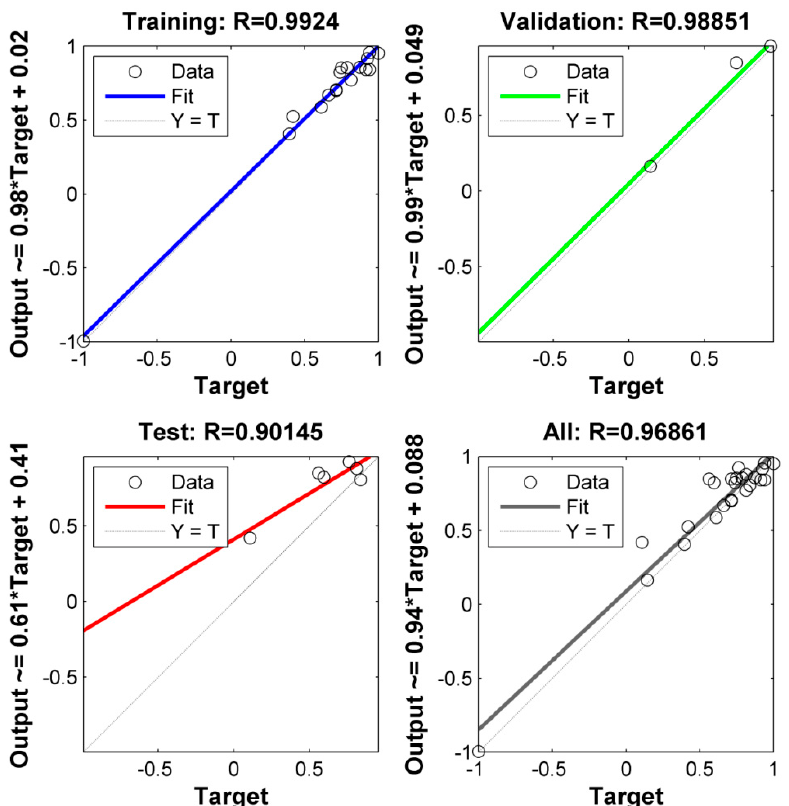
Figure 5. Training, testing, and validation performances of the 4-3-3-1 neural network architecture for the prediction of fractal dimension in WEDM.